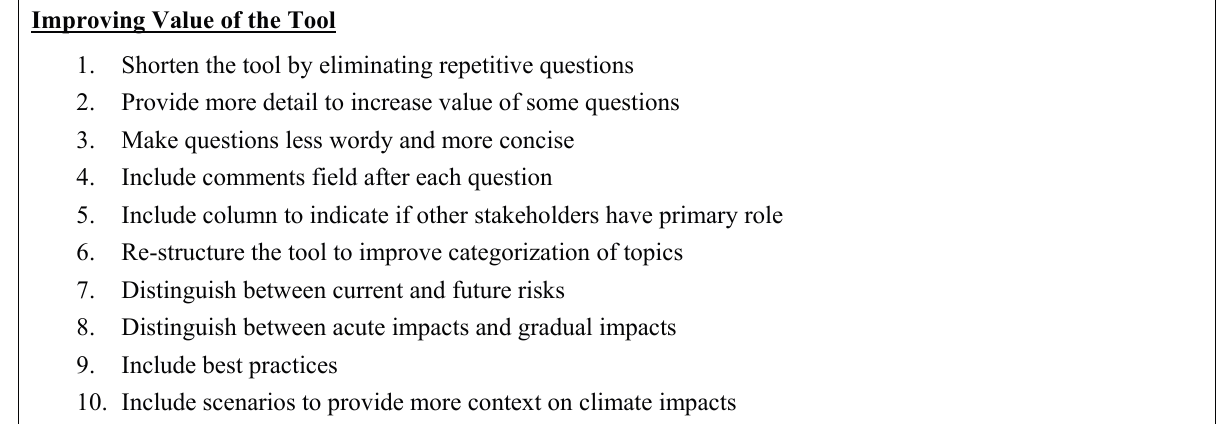
Table 4. Suggestions from interviewees on how to improve the